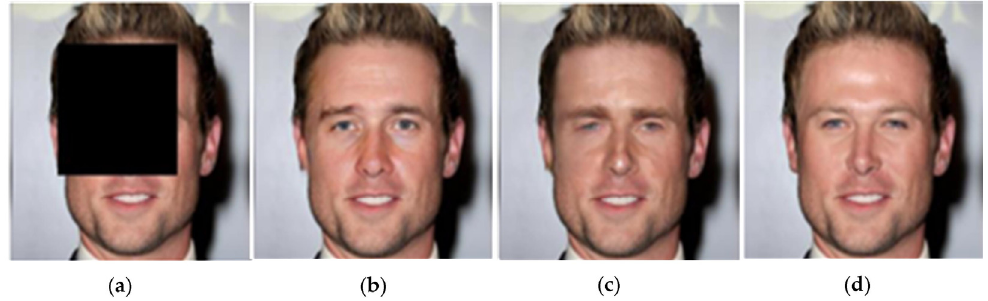
Figure 10. Inpainting results of using local discriminator or RED. ( a ) Input image of the network; ( b ) Result of using local discriminator; ( c ) Result of using RED; ( d ) Ground truth.